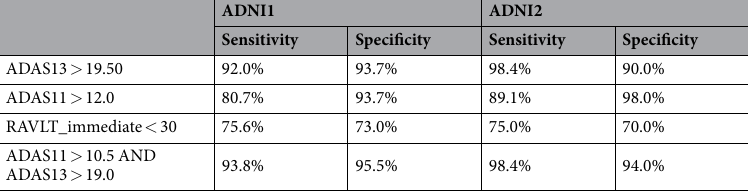
Table 4. Sensitivity and specificity of classifiers for identifying Rapid Declining Effect of Gender on Rapid versus Slow Decliner Status.